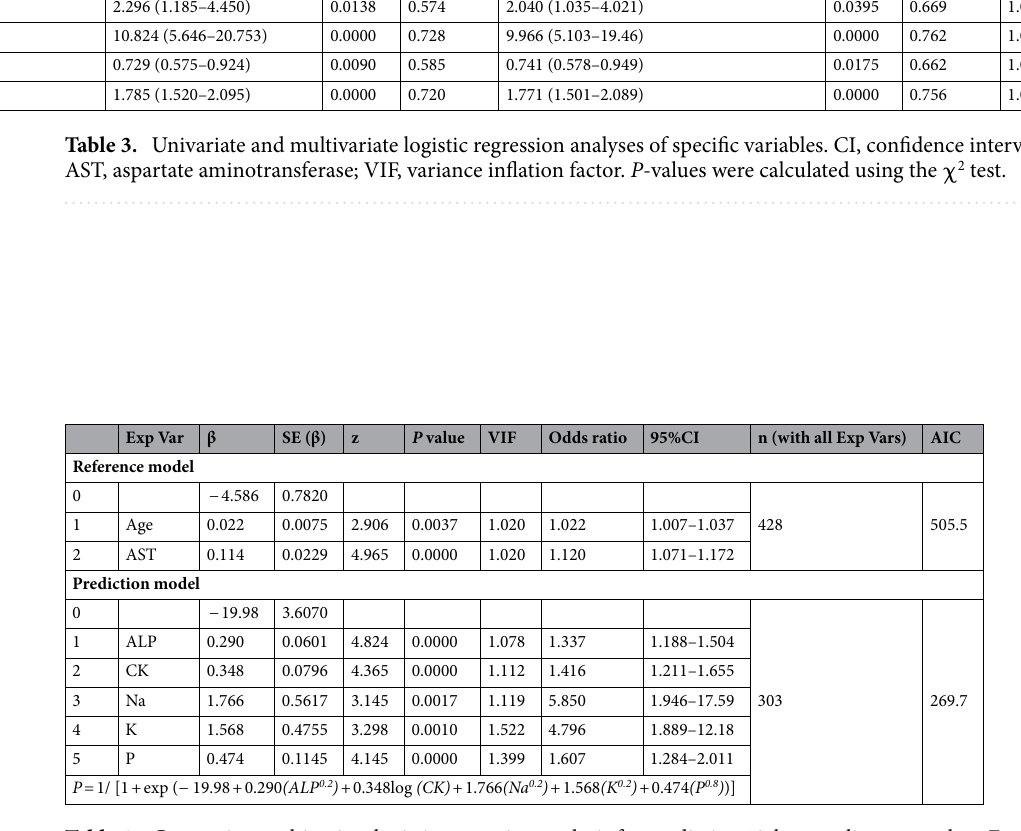
Table 4. Comparing multivariate logistic regression analysis for predicting 72-h mortality. n, number; Exp Var, explanatory variable; SE, standard error; z, z value; VIF, variance inflation factor; CI, confidence